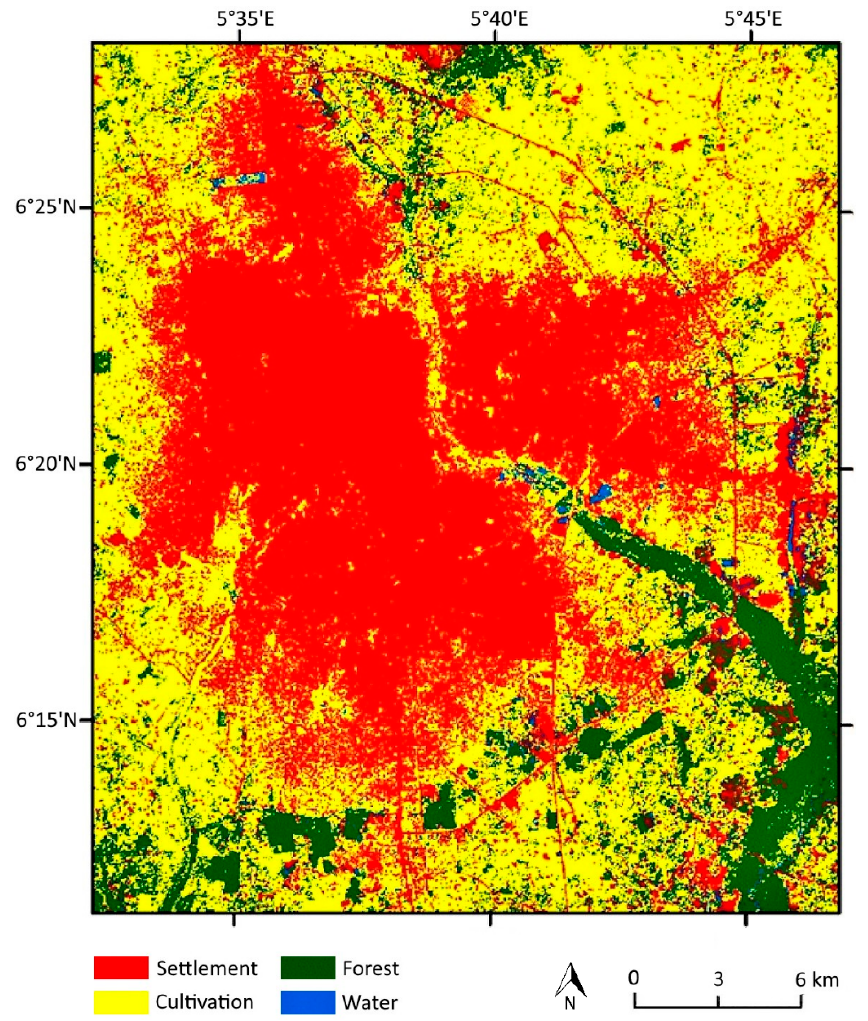
Figure 5. Land use image map of Benin City.